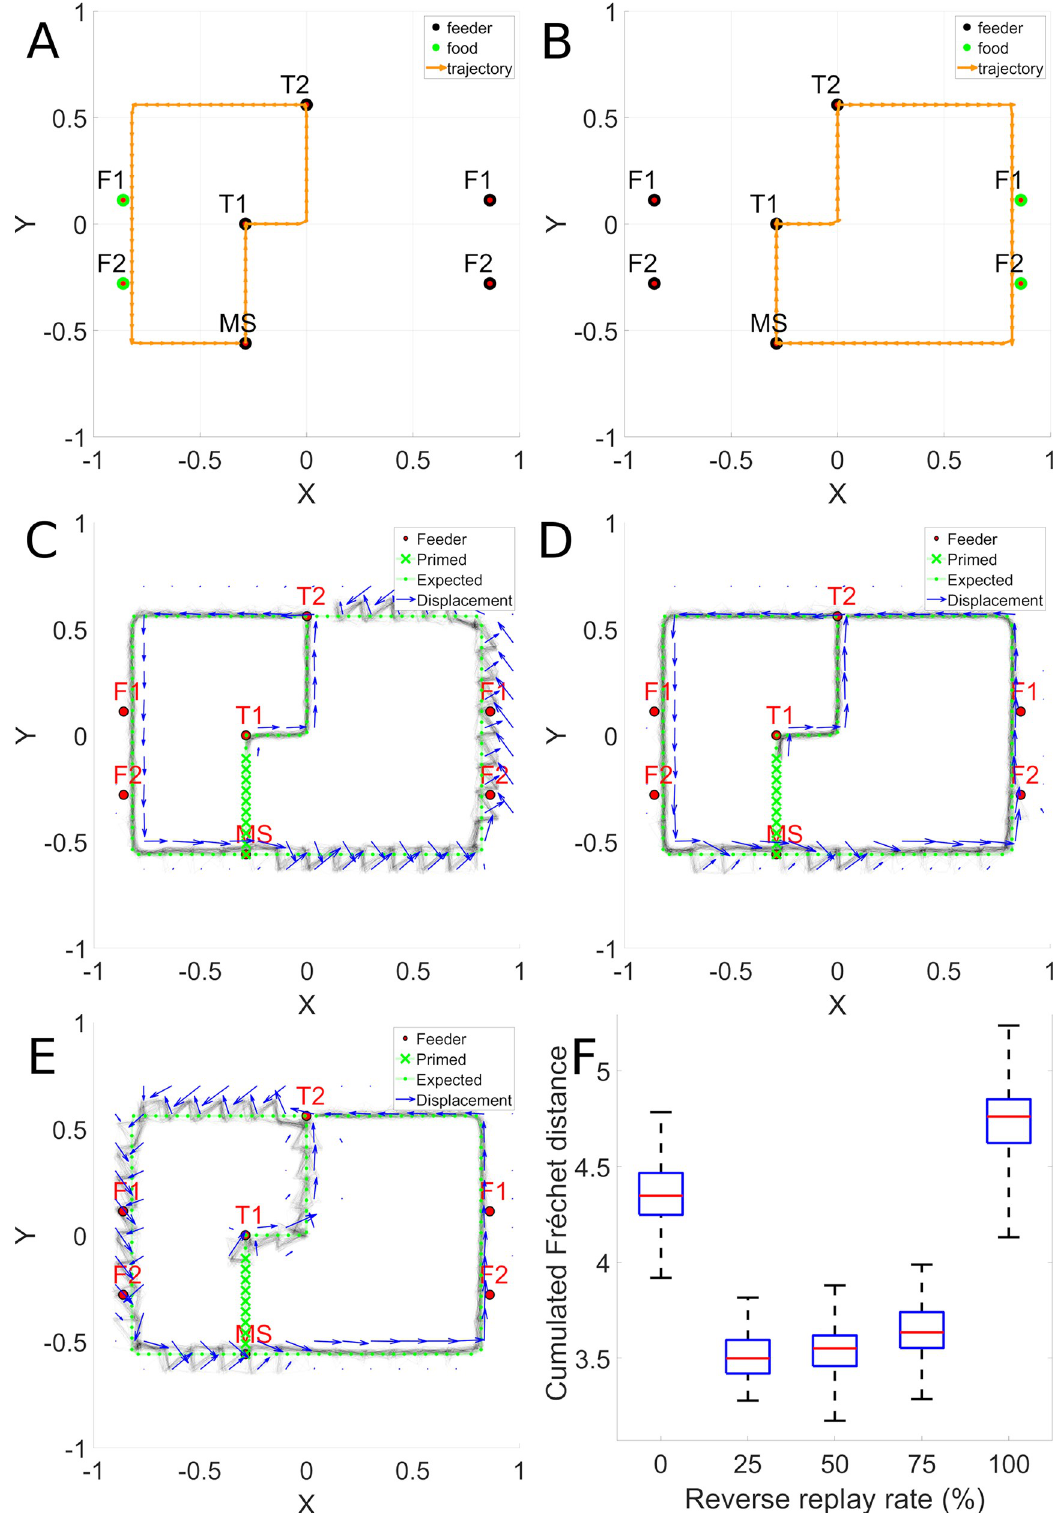
Fig 9. Reverse replay allows novel shortcut path generation. Panels A and B illustrate the trajectories for left and right trajectories, based on Gupta et al. After training on these two trajectories, we test the ability to generate a shortcut that makes the